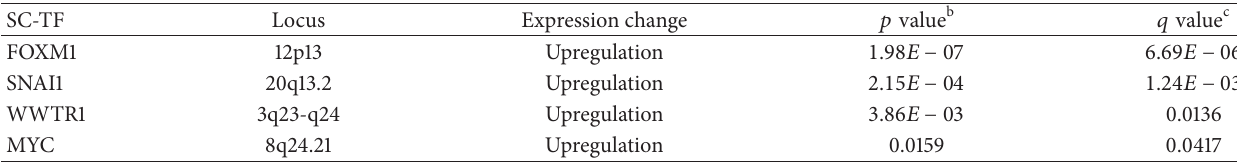
Table 2: Cooccurrence of SC-TFs with CDH2, 4, 6, and 17 by RPPA analysis a